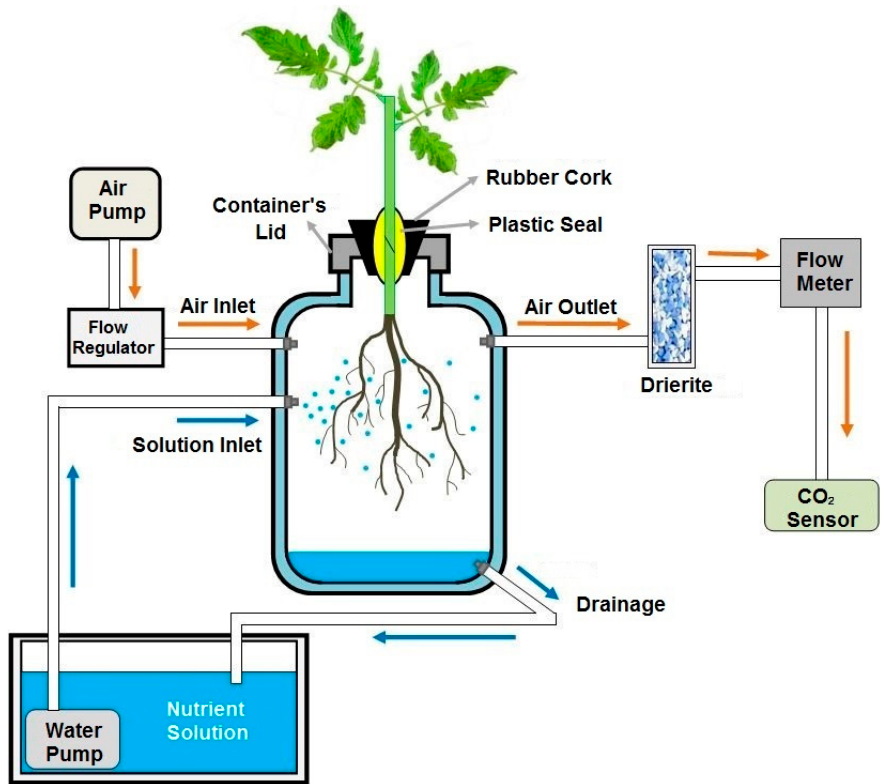
Figure 6. Diagram of the system used to measure root respiration rates.